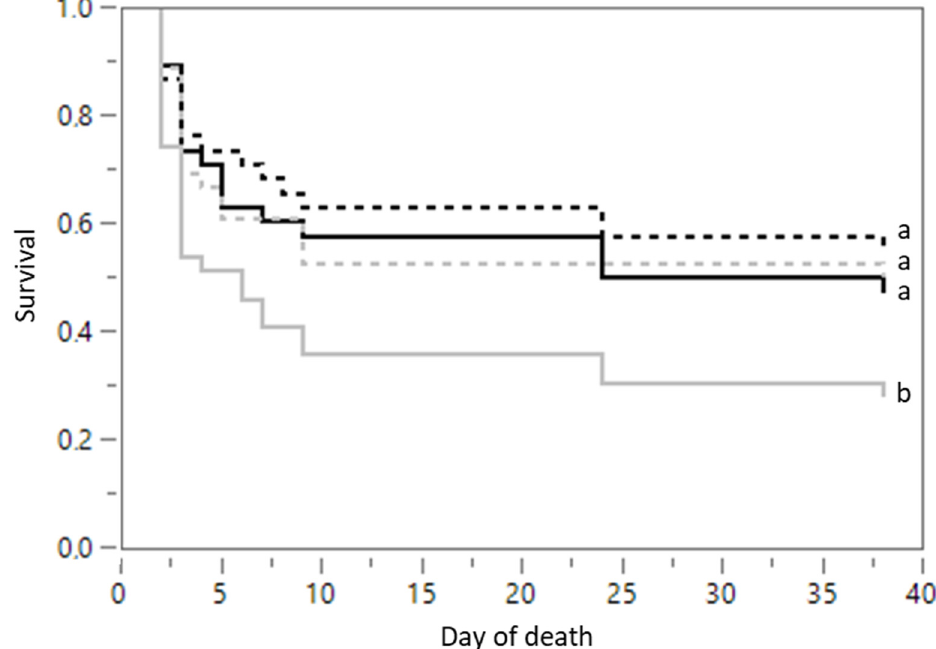
Figure 2. Cumulative mortality of low-birth-weight piglets that were drenched with milk replacer (dashed black line; n = 38), colostrum (full black line; n = 38), quercetin (dashed grey line; n = 36) or short-chain fructo-oligosaccharides (scFOS; full grey line; n = 39) over time. Significant differences (Cox’s proportional hazard model, Kaplan-Meier survival plot, p ≤ 0.05) between treatments are indicated by a different letter (a–b).